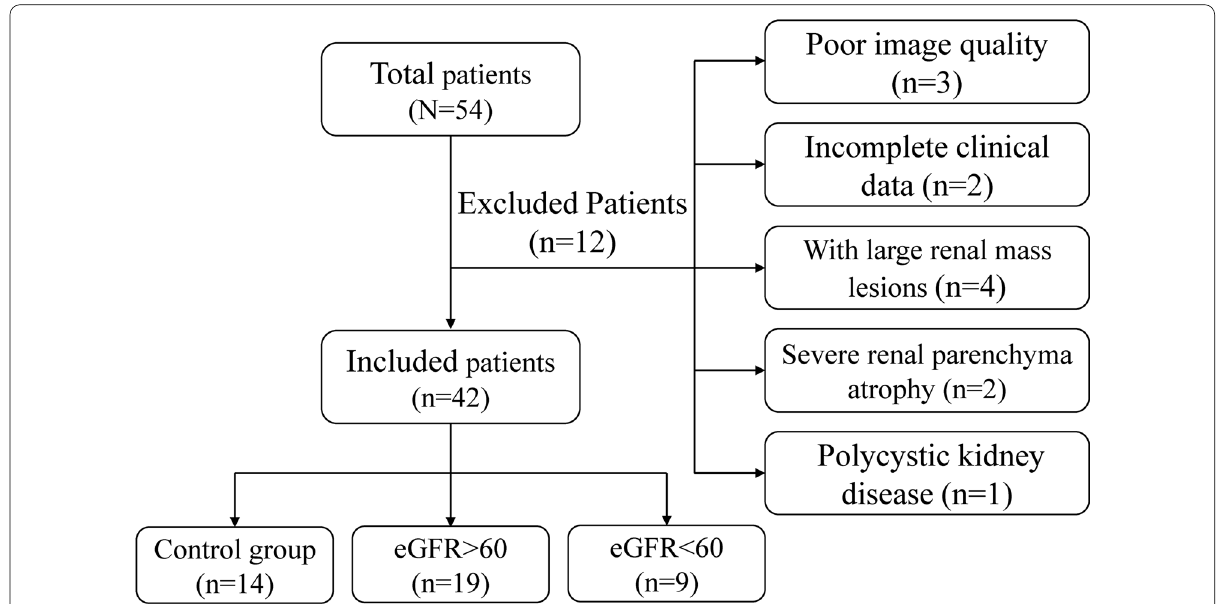
Fig. 1 Flowchart of the study